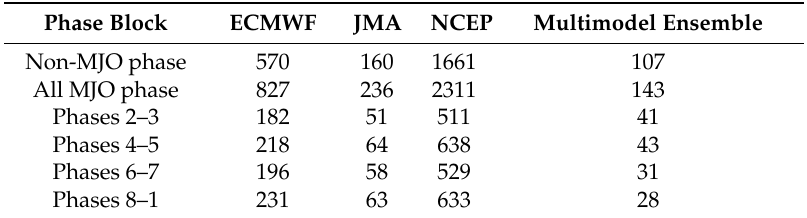
Table 3. The number of individual forecasts, each with its own forecast period, starting from each piecewise area in the Madden–Julian Oscillation (MJO) phase space. Phase Block ECMWF JMA NCEP Multimodel Ensemble Non-MJO phase 570 160 1661